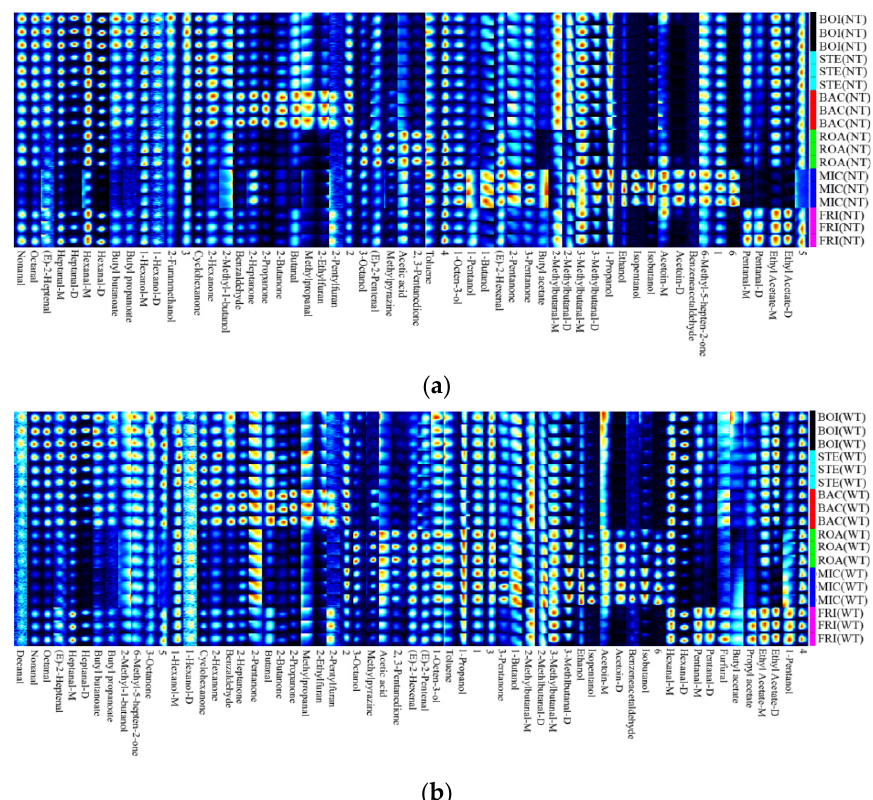
Figure 6. The analysis of volatile flavor substances by fingerprint map of surimi products subjected to different thermal treatment methods. ( a ): NT; ( b ): WT; BOI: boiled D. maruadsi surimi products; STE: steamed D. maruadsi surimi products; BAC: back-pressure sterilized D. maruadsi surimi products; ROA: roasted D. maruadsi surimi products; MIC: microwaved D. maruadsi surimi products; FRI: fried D. maruadsi surimi products; NT: group of without TGase; WT: group of with TGase.